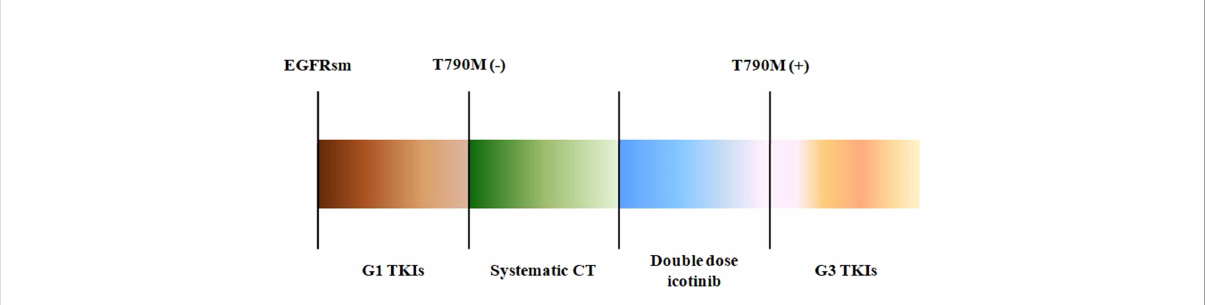
FIGURE 4 The treatment procedures of the three patients. EGFRsm, epidermal growth factor receptor sensitive mutation; TKIs, tyrosine kinase inhibitors; G1, fi rst-generation TKIs; G3, third-generation TKIs; CT,